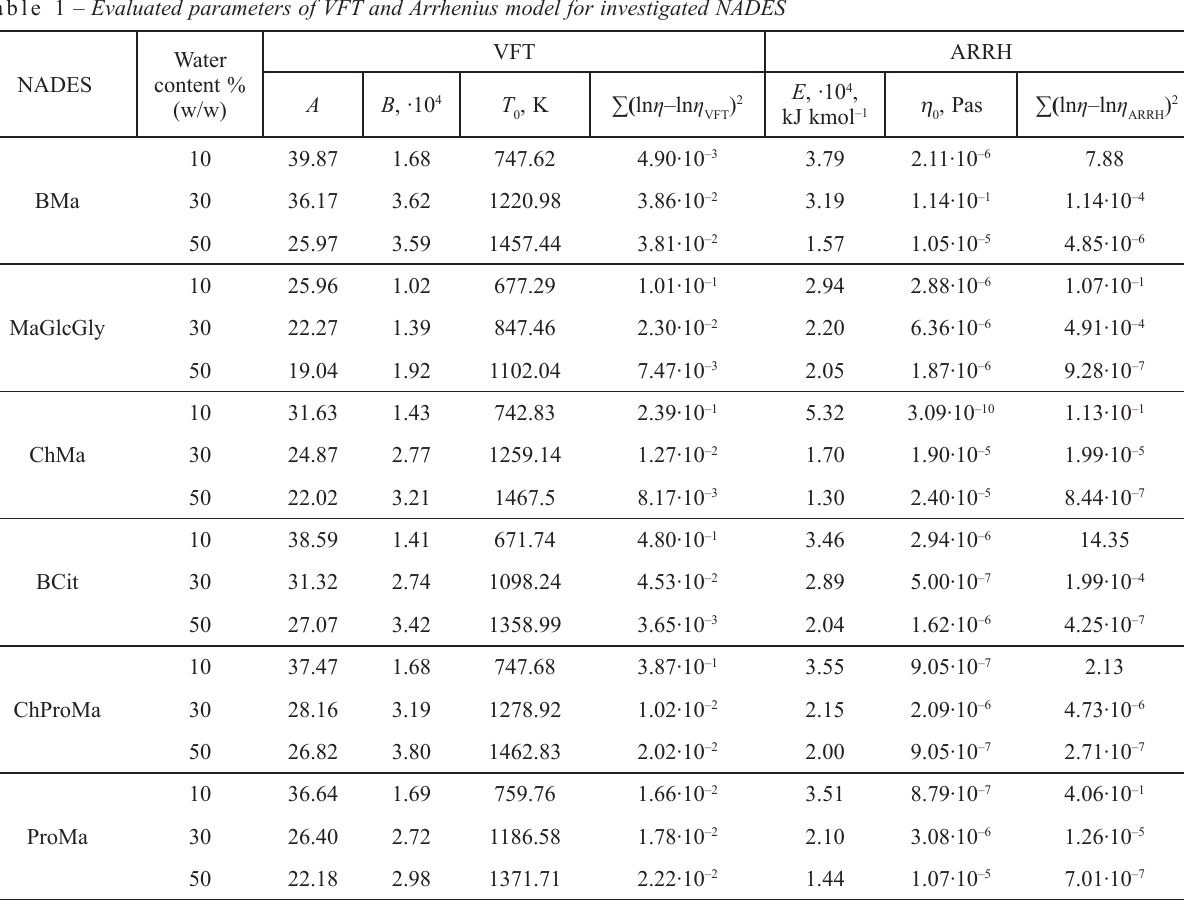
Table 1 – Evaluated parameters of VFT and Arrhenius model for investigated NADES